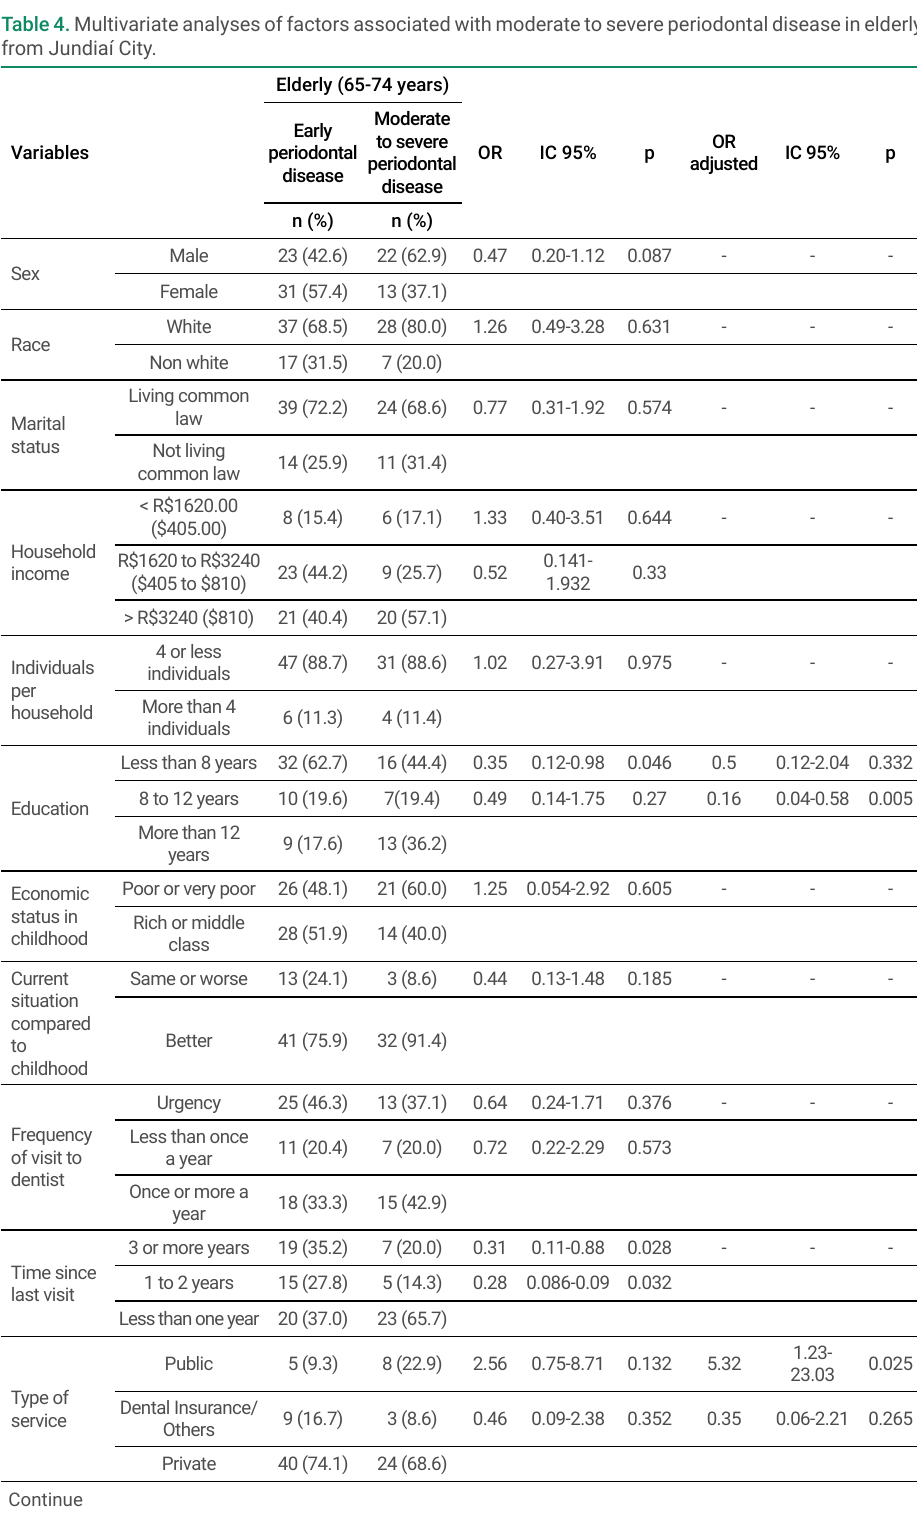
Table 4. Multivariate analyses of factors associated with moderate to severe periodontal disease in elderly from Jundiaí City.